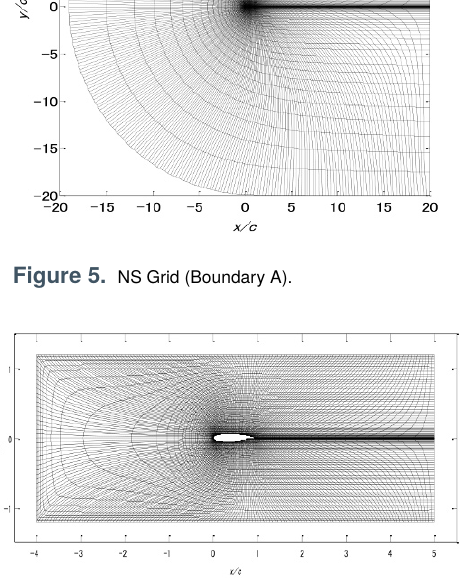
Figure 6. NS Grid for Boundary C.